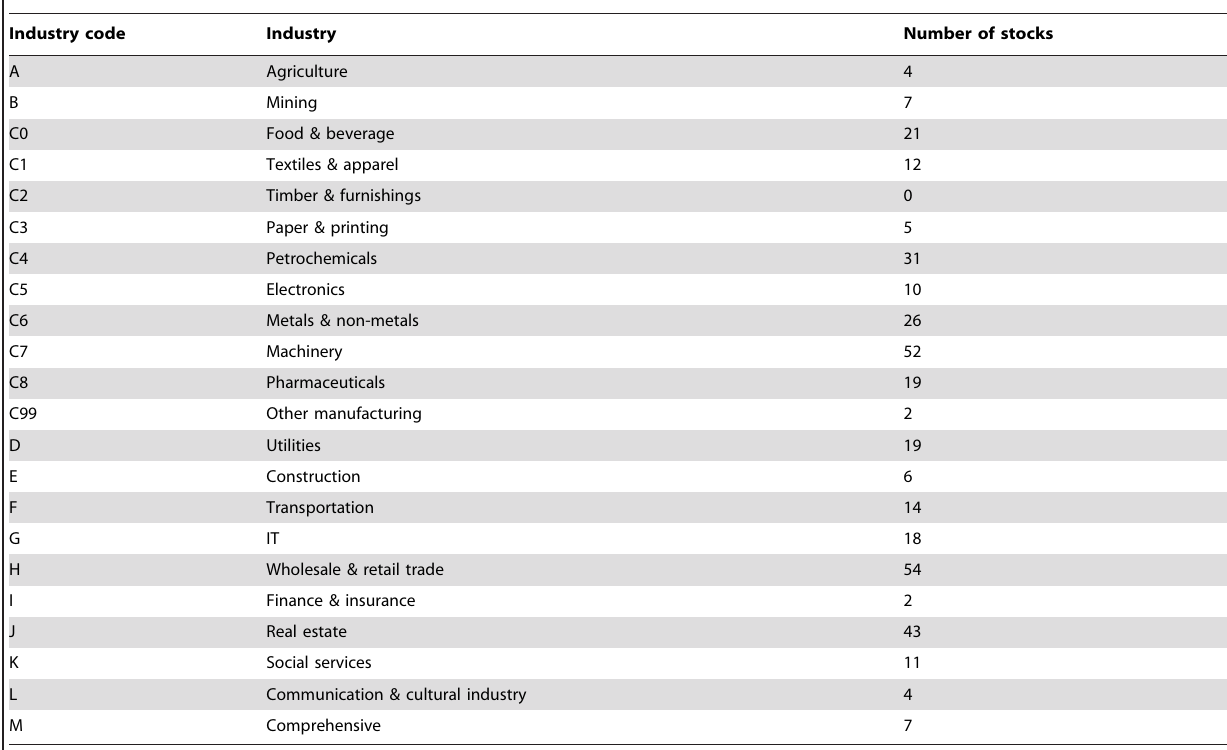
Table 1. Basic information about the A-M conventional